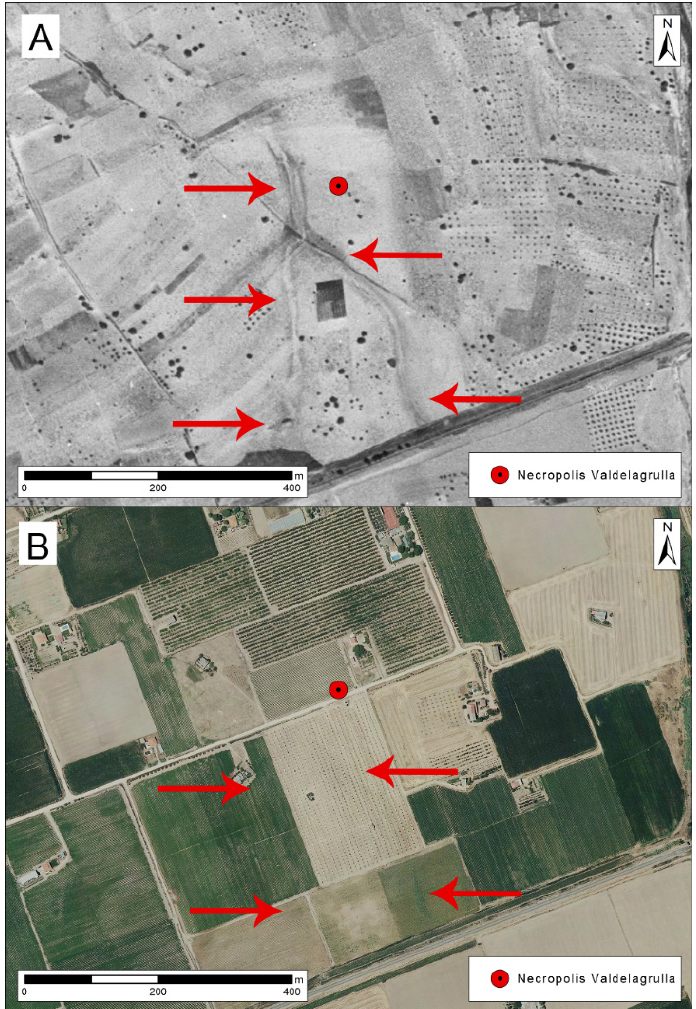
Figure 3. Comparison between a still from the American Flight of 1945/1946 ( A ) and an image corresponding to the PNOA Máxima Actualidad ( B ), where we can see the impact that the Badajoz Plan caused by cutting off paleochannels that were filled in and are now used as farming areas. The images show how two branches of the River Ortigas, a tributary of the Guadiana which flowed next to the Iron Age necropolis of Valdelagrulla, have been eliminated and are now occupied by orchards.